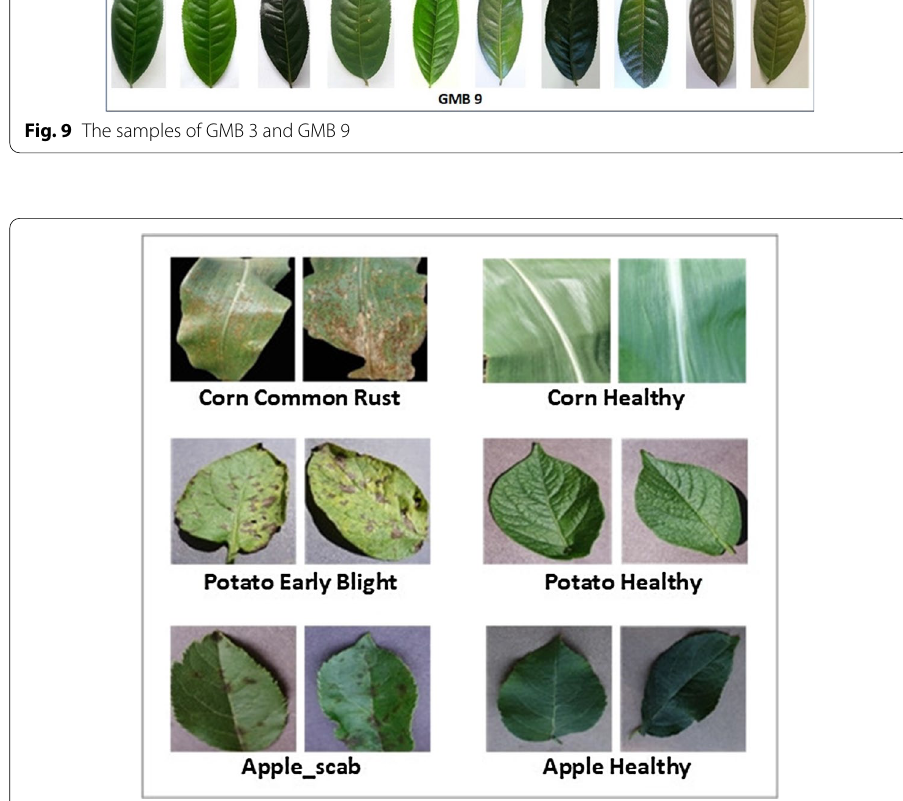
Fig. 10 The samples of PlantVillage